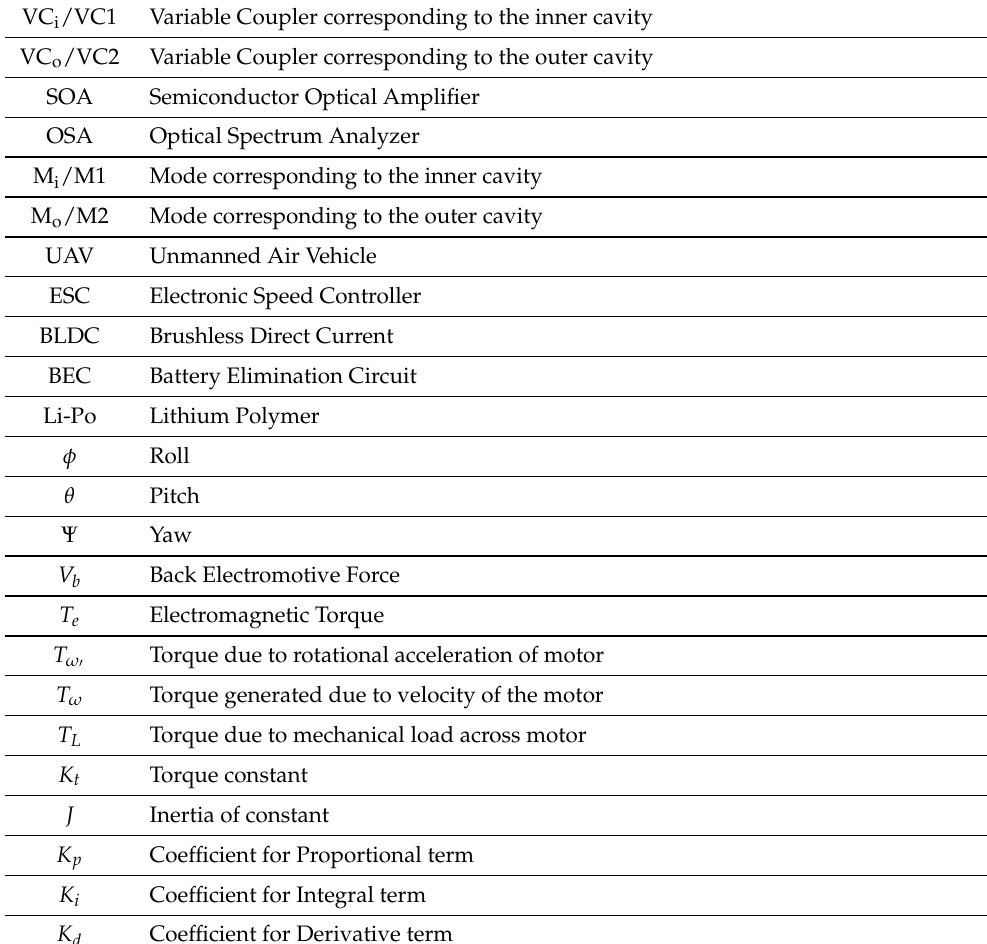
Table 1. List of